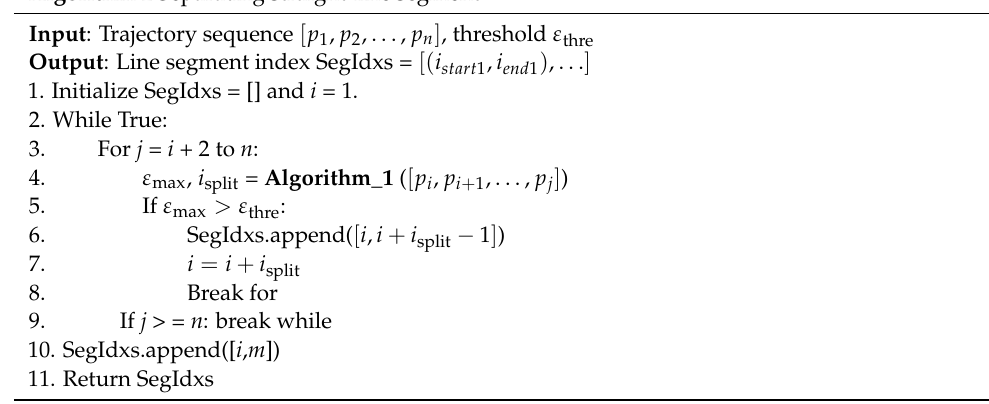
Algorithm 2 Separating straight-line segment